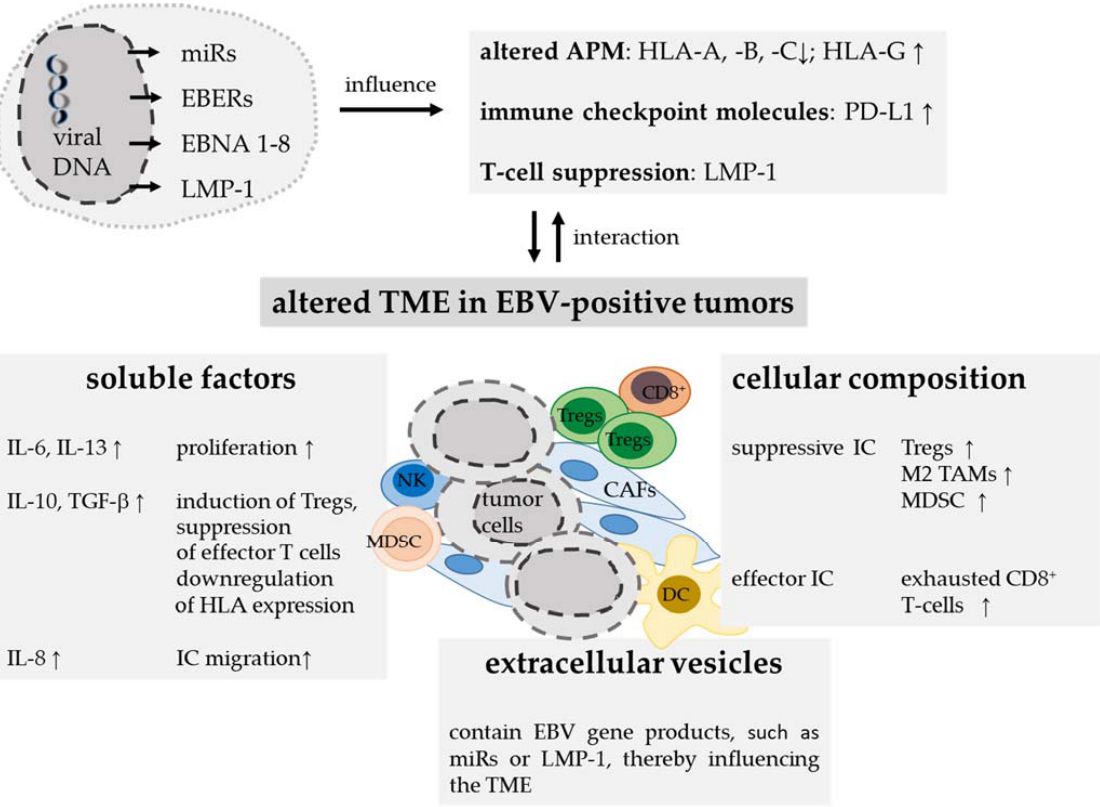
Figure 2. Composition of the TME in EBV-positive tumors. EBV gene products influence innate and adaptive immunity and thereby modulate the TME. Latent membrane protein (LMP) 1 suppresses the function of effector T cells and can be presented by tumor cells, extracellular vesicles or antigen-presenting cells (APCs) such as dendritic cells (DCs) via human leukocyte antigen (HLA) class II molecules. In addition, EBV-genome-related miRs influence the HLA class I antigen processing machinery (APM). Other strategies of the tumor cells to escape the immune surveillance are upregulation of non-classical HLA-G and/or immune checkpoint molecules, such as the programmed death ligand-1 (PD-L1). Furthermore, EBV-positive tumors induce a highly variable composition of the TME with increased numbers of different immune cell subsets, in particular high frequencies of effector T cells, regulatory T cells (Treg) and M2-polarized macrophages. It has been shown that soluble factors, secreted by tumor cells, cancer-associated fibroblasts (CAFs) or even other immune cells (ICs) promote immune cell migration into the TME. Furthermore, soluble factors such as interleukin-10 (IL-10) can induce Tregs, suppress effector T cells and regulate HLA class I